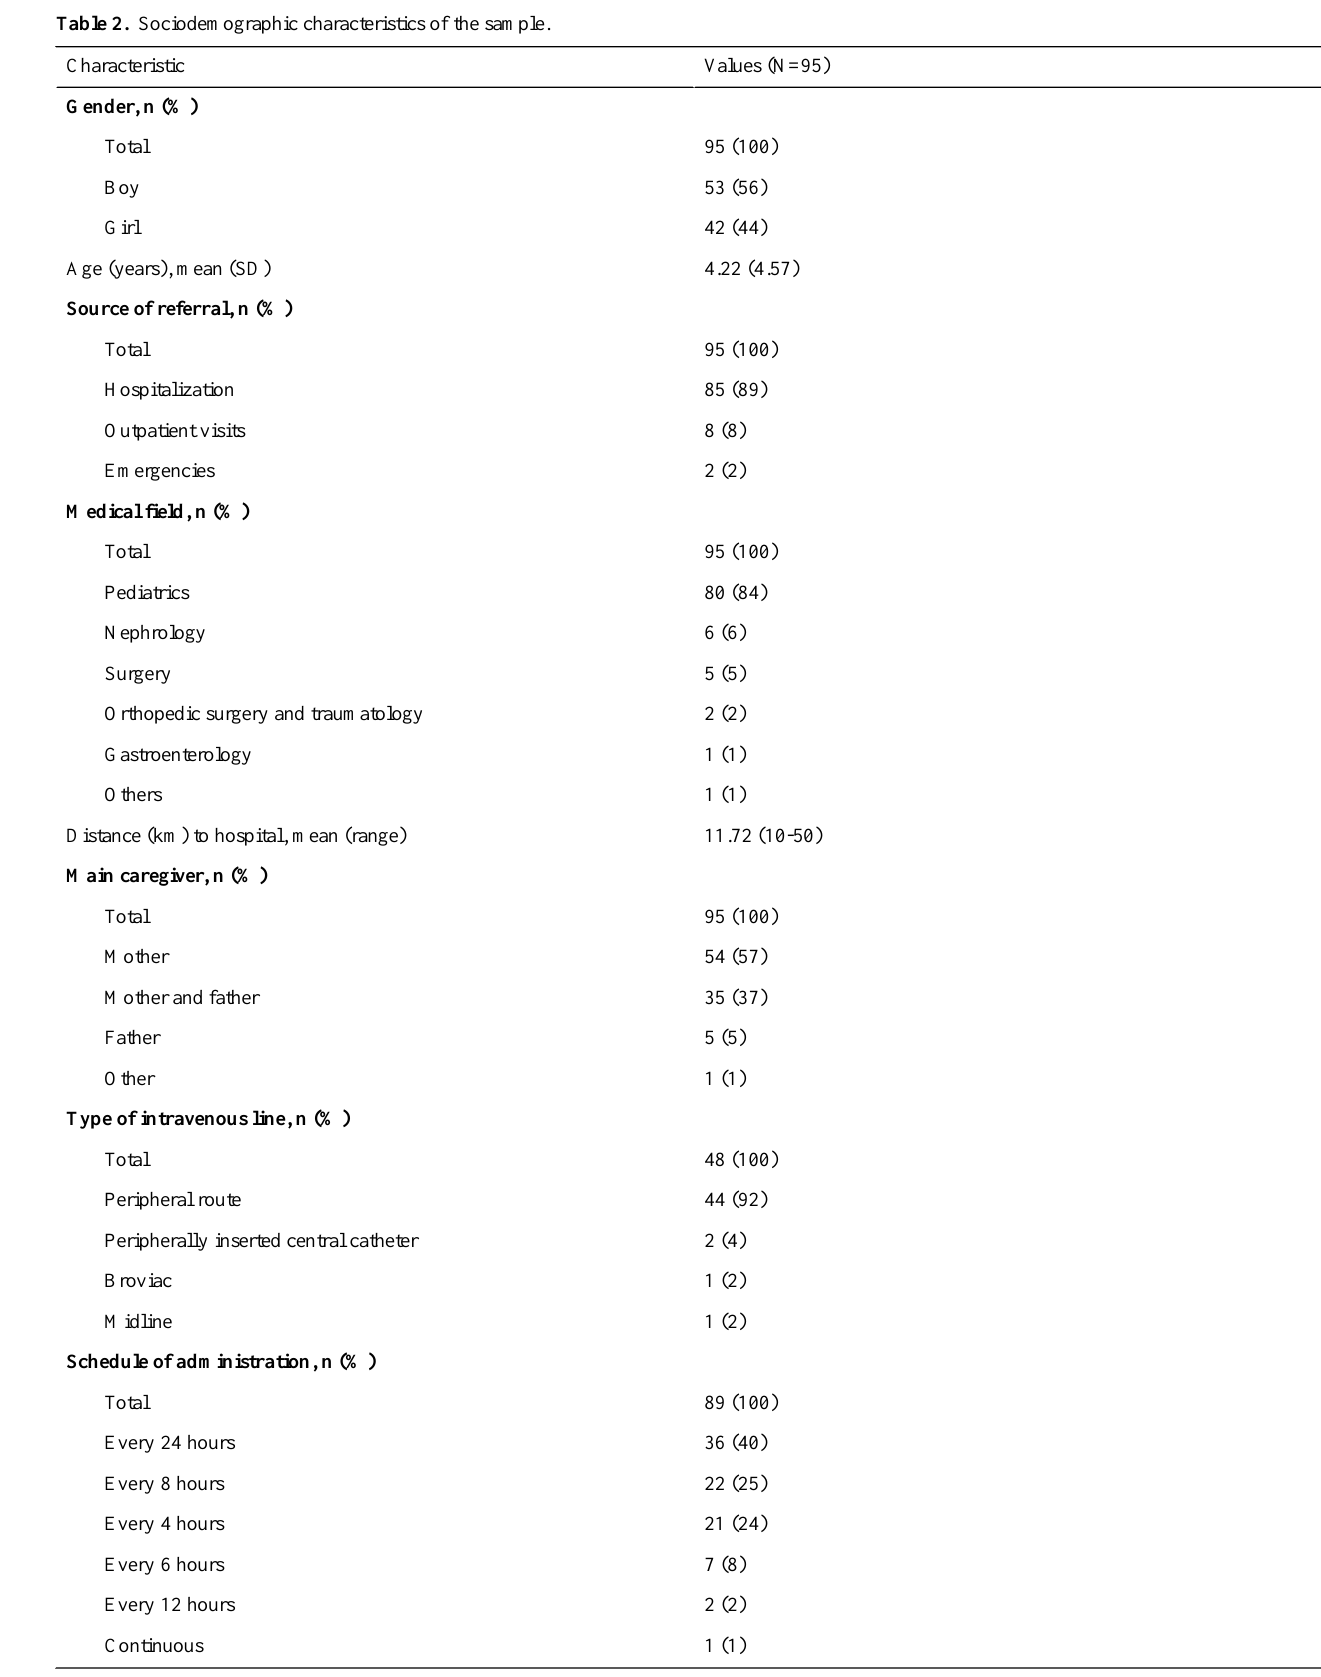
Table 2. Sociodemographic characteristics of the